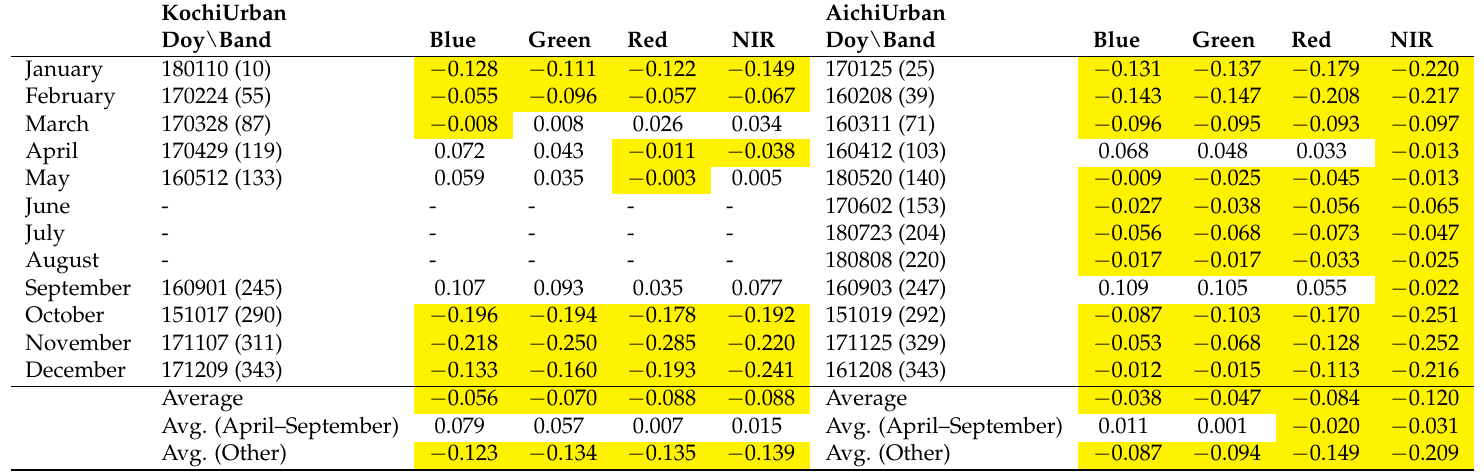
| − | 1 − r | for the two urban ROIs. Negative values indicate that the RAM method performed better than the SZM Table 8. Summary of | 1 − r j j SZM RAM